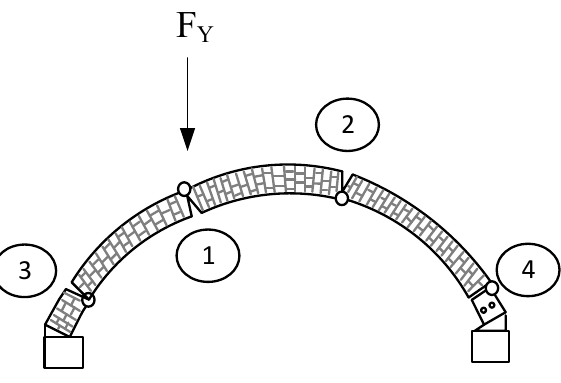
Figure 28. Sequence of hinges formation on the unrepaired arches [118].